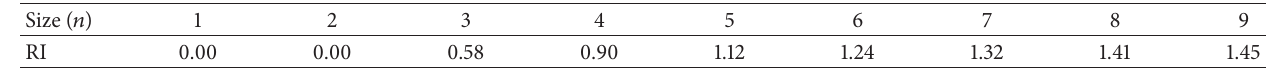
Table 2: The random consistency index